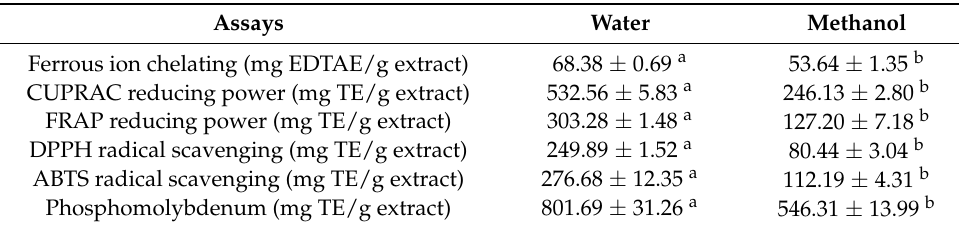
Table 2. Antioxidant activities of S. cretica ssp. anatolica extracts x. . Assays Water Ferrous ion chelating (mg EDTAE/g extract)